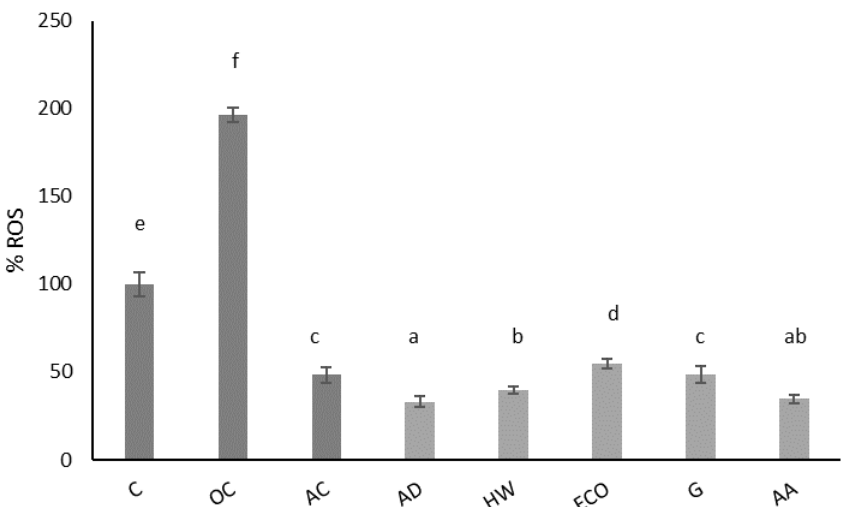
Figure 2. Effect of aqueous extracts obtained from different kiwi fruits (1 mg/mL) on the physiological ROS of IEC-6 intestinal cells. C: control — untreated cells; OC: oxidation control — tBOOH (1 mM); AC: antioxidant control —vitamin C (10 μg/mL); AD: A. deliciosa ; HW: A. deliciosa var. Hayward; ECO: A. deliciosa var Hayard eco; G: A. chinensis; AA: A. arguta . Data are shown as the mean ± SD of three independent experiments. Different letters above columns indicate significant differences among treatments (Duncan test, p ≤ 0.05). Different shadow color has been used to differentiate controls and samples.